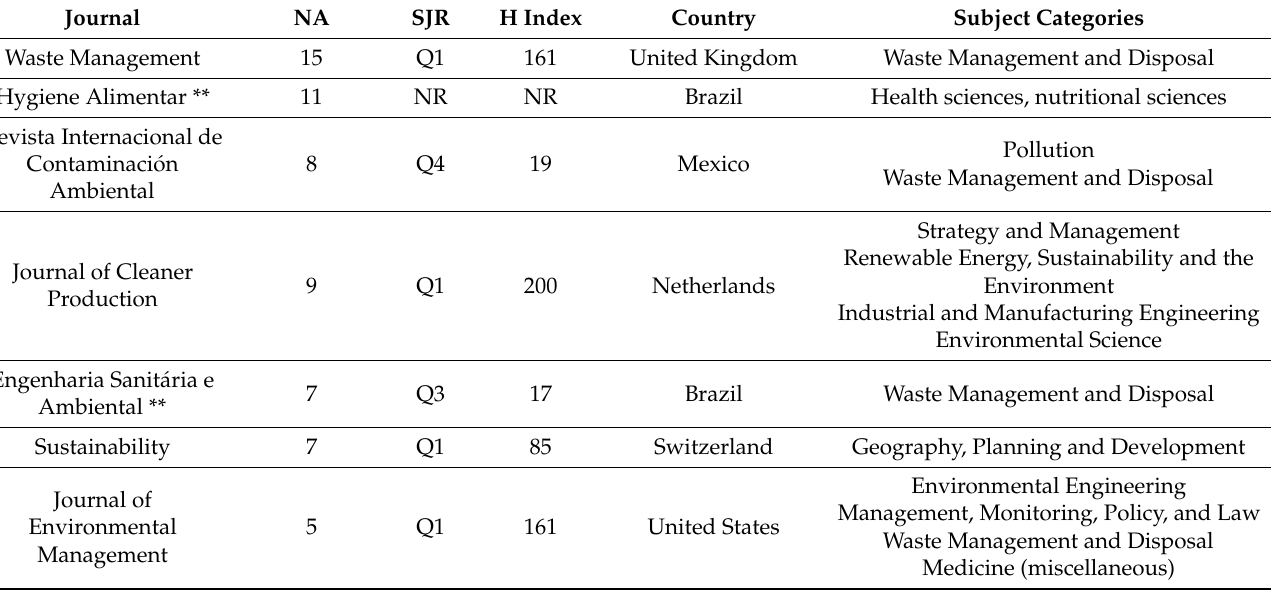
Table 3. Journals with the highest number of